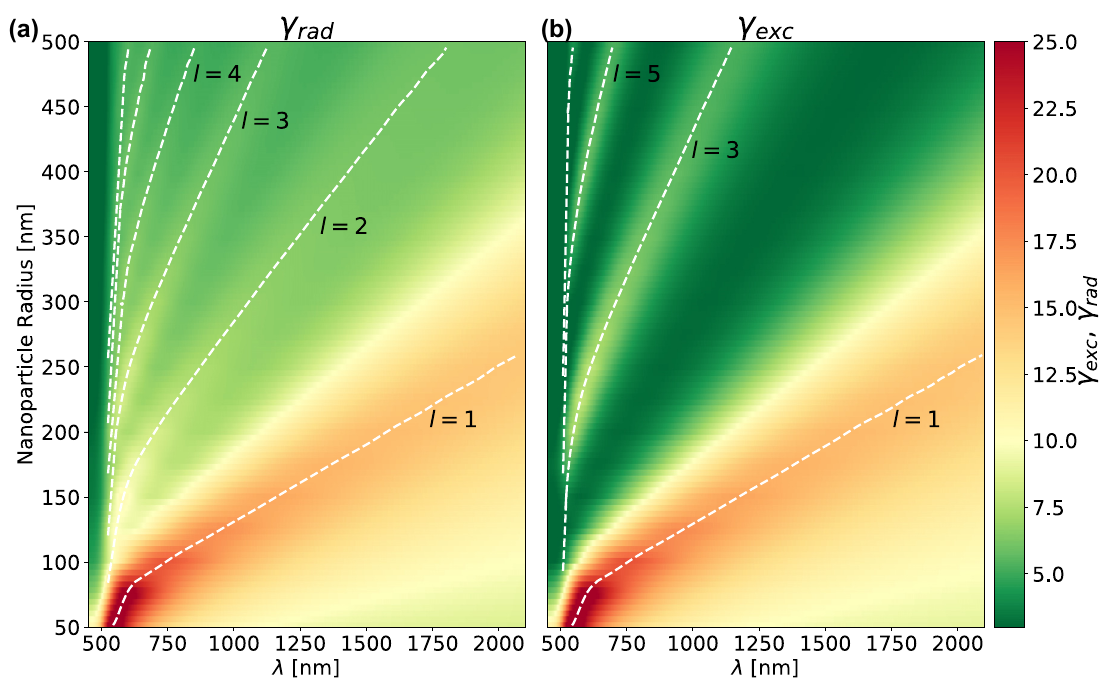
and (b) 𝛾 for isolated gold NPs obtained analytically from the multipolar decomposition, as a function of wavelength Figure 4: The (a) 𝛾 rad exc and the NP radius—ranging between 50–500 nm. The white dashed lines highlight the maxima curves for each l -labelled resonance. source and a detector; Eqs. (2) and (4) are actually